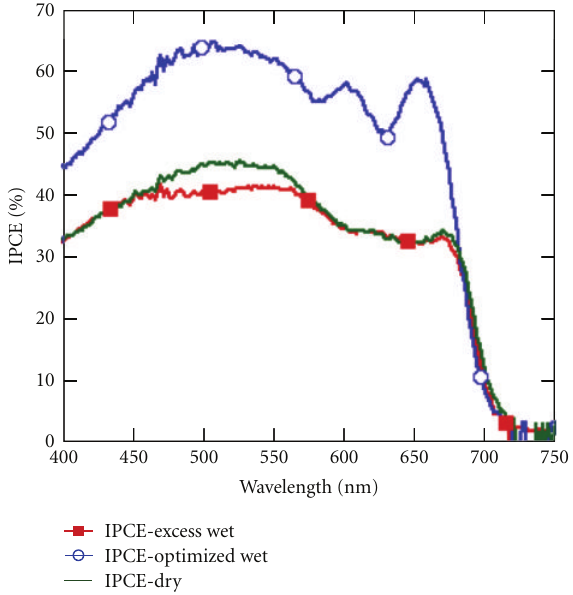
Figure 11: IPCE of an FTO/TiO 2 nanotube array/SQ-1 dye/P3HT/ PEDOT:PSS/Au solar cell, where the P3HT layer was prepared with di ff erent degrees of surface wetness prior to a 150 ◦ C postbake. Excess wetness, where the film was still wet entering the postbake; dry, indicating where the film had dried on the spinner prior to postbake; optimized, where upon just visually drying the device was immediately removed from the spinner and exposed to the postbake. The dye sensitization and PEDOT:PSS layer are identical in all the three samples. Nanotube array films of 35 nm average pore diameter and 600–700 nm length were used. Reprinted with permission from